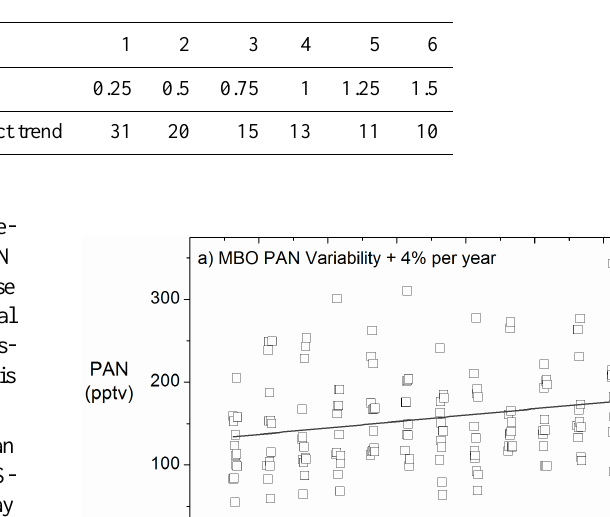
Table 1. Number of springtime campaigns to detect a range of real trends in PAN or O 3 in the Eastern Pacific lower free troposphere with a probability of 95%. A real trend is indicated at the 95% confidence level.